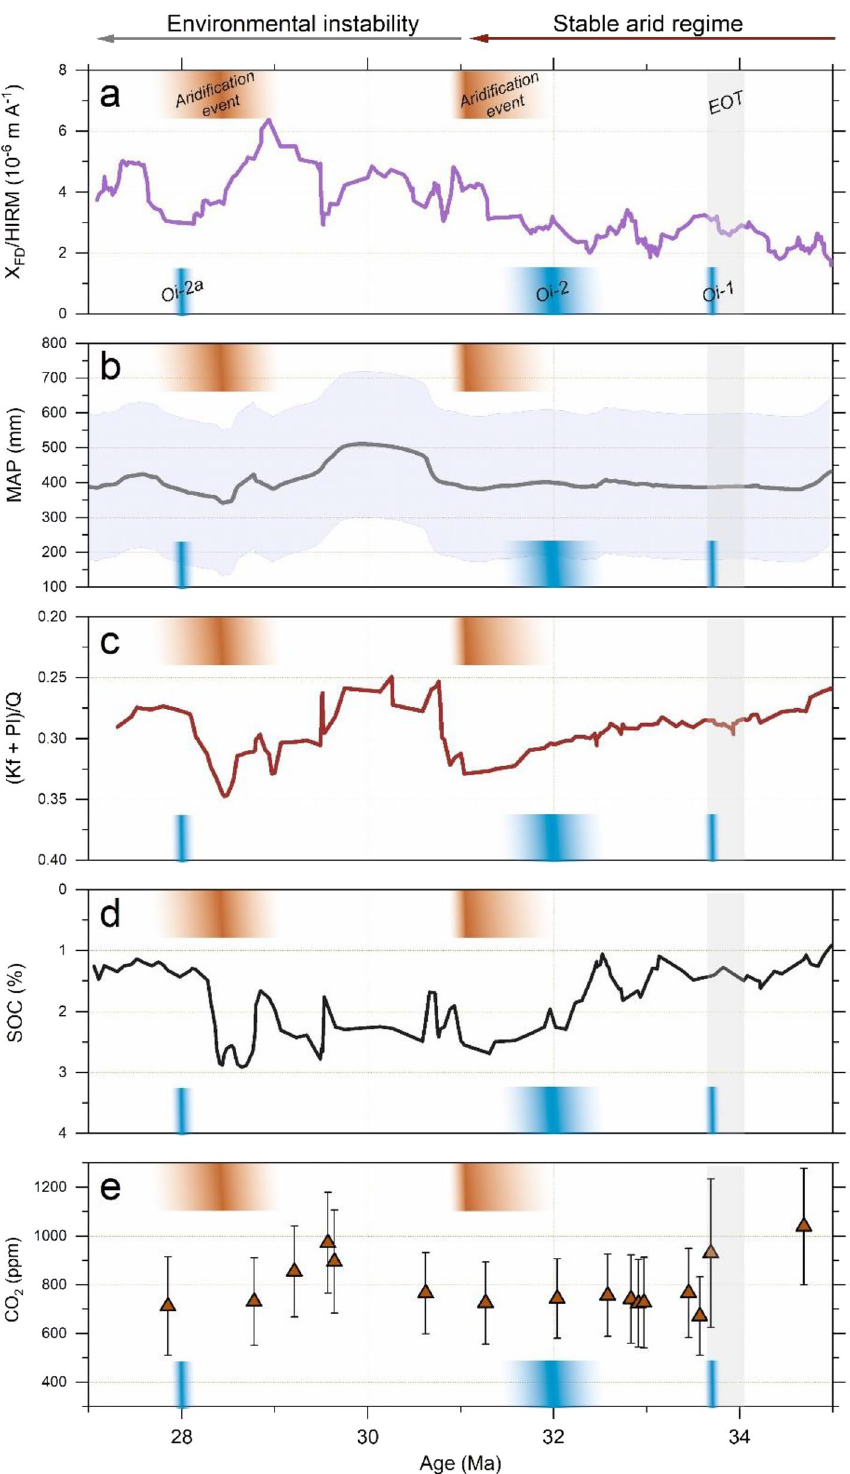
Figure 3. Changes in aridity within the Bayanhot Basin inferred from ( a ) the χ FD /HIRM ratio. The curve shown is constructed from data filtered from outliers and smoothed with a 10-point running average. ( b ) Mean annual precipitation (MAP) based on the RF-MAP2.0 model 43 , with the shaded area indicating an error of ± 209 mm. ( c ) Weathering intensity as indicated by the ratio of feldspars to quartz (Kf + Pl)/Q. ( d ) The soil organic carbon (SOC) content. In ( b – d ) the curve is smoothed with a 5-point running average. ( e ) Atmospheric CO 2 reconstruction based on alkenones (orange triangles) 59 . The EOT and Oi-1 8 , Oi-2 and Oi-2a glaciations 60–62 , as well as the two major aridification events are indicated in the figure. Note that the y-axis scale in panels ( c , d ) is